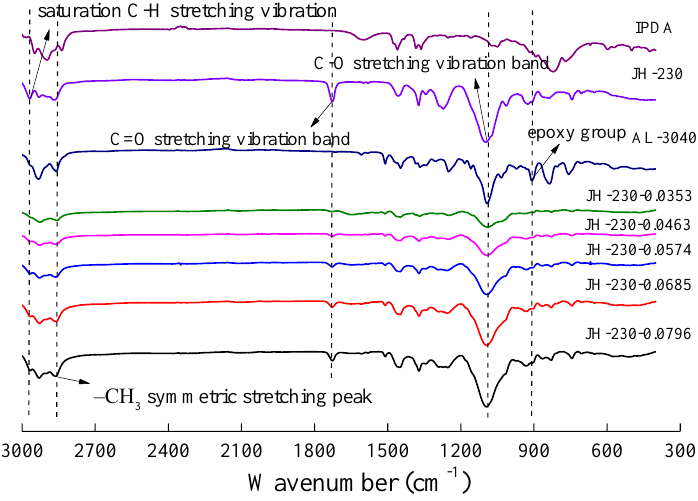
Figure 9. FT-IR Spectra of IPDA, JH-230, AL-3040, and the SM-HEP-AM.